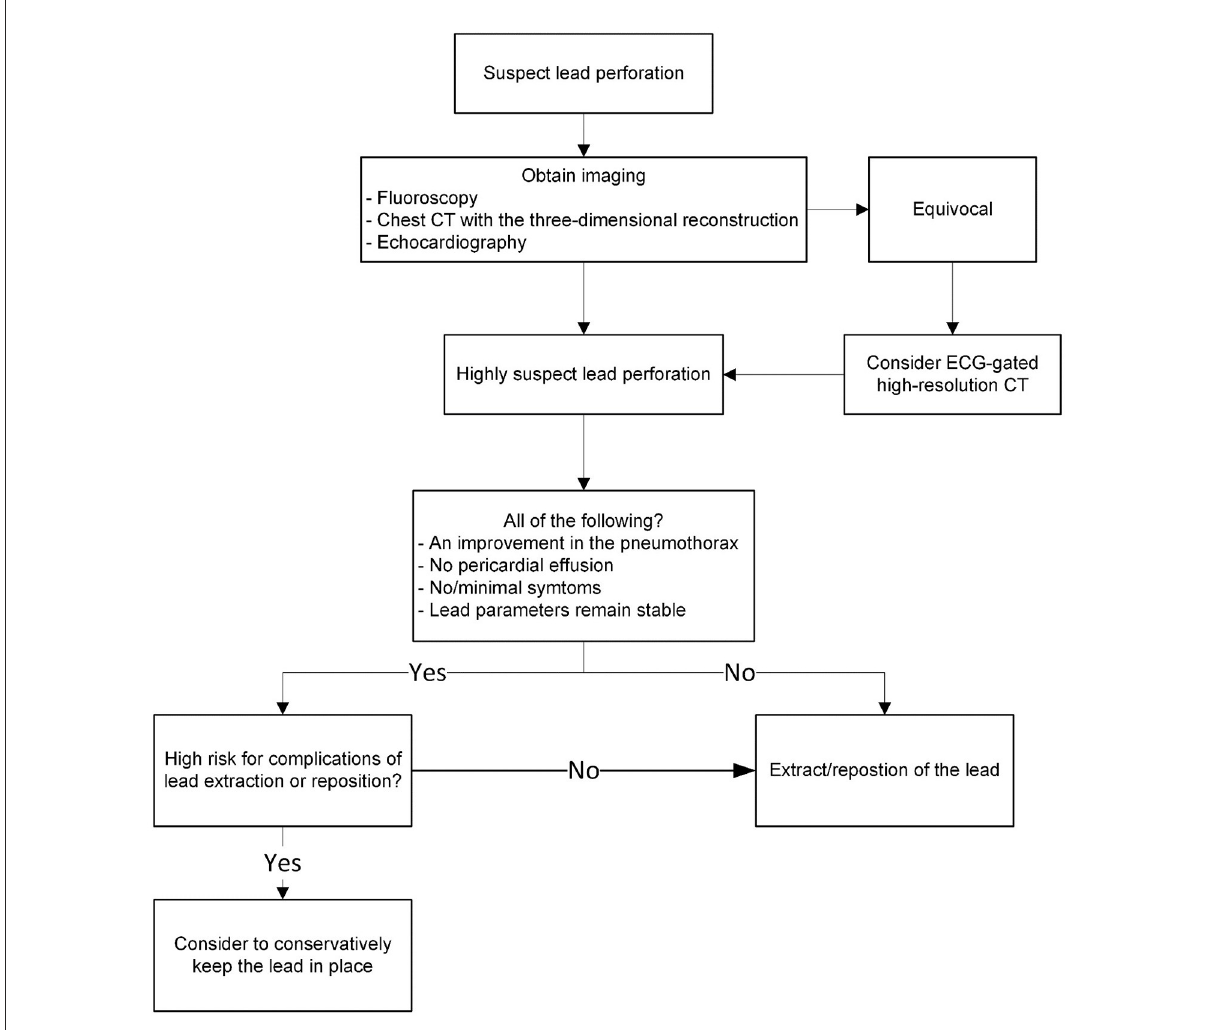
FIGURE4 The evaluation of the need for lead extraction or